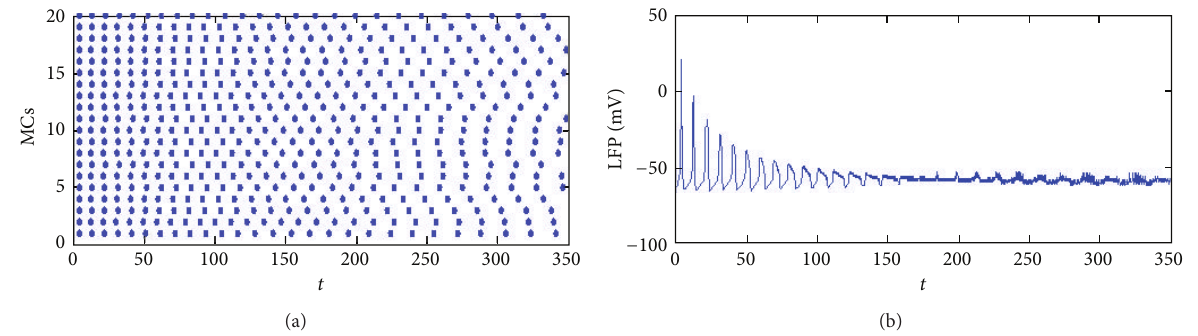
= 0 . (b) LFP of twenty MCs when 𝑔 GABA